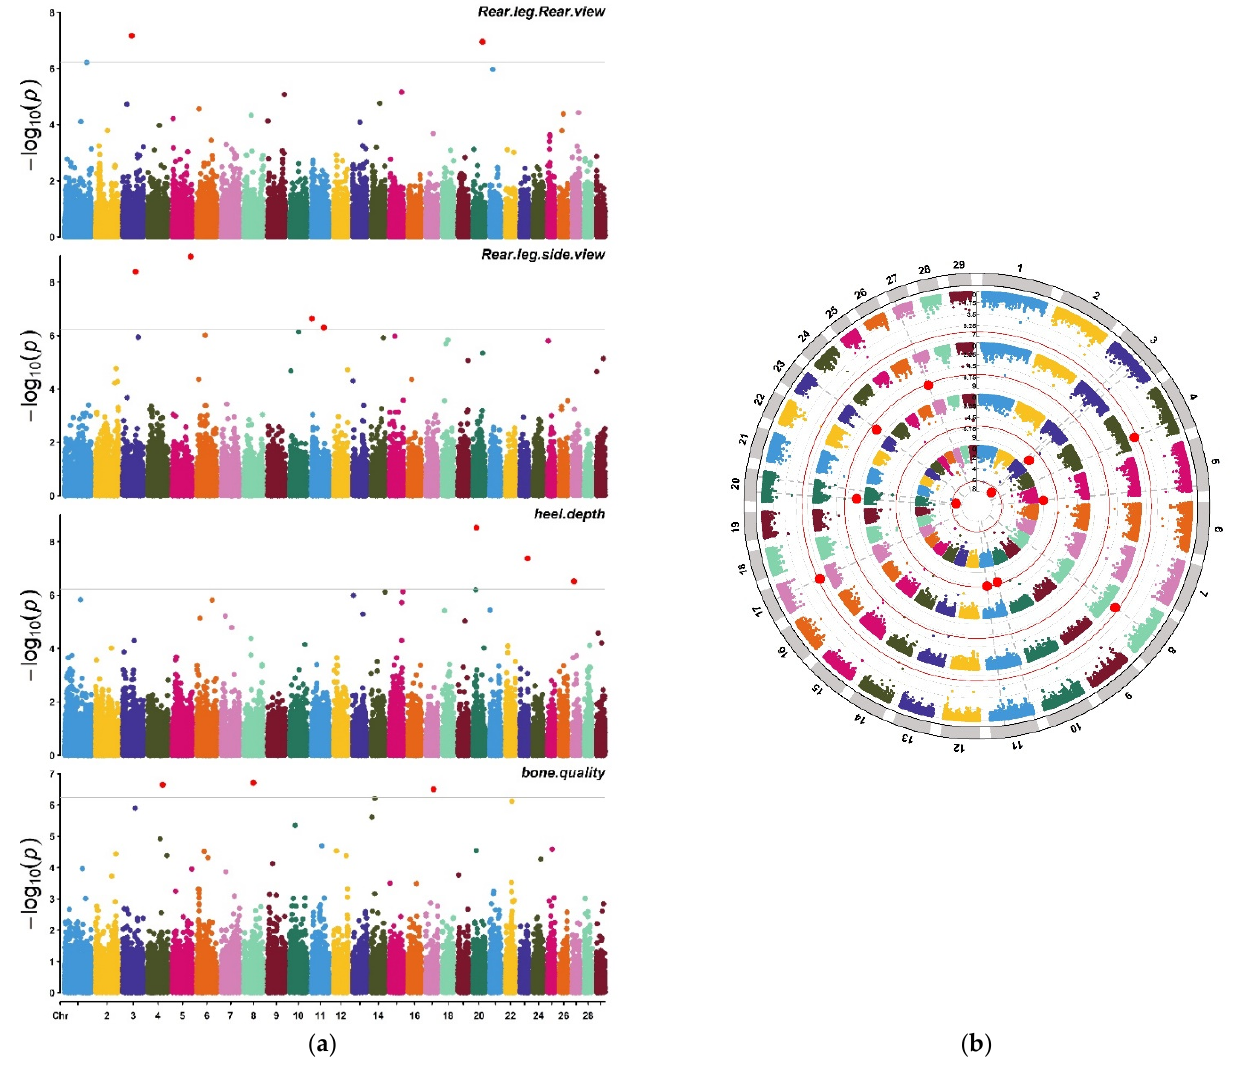
Figure 4. Manhattan from GWAS for feet and leg traits in Chinese Holstein cattle. Manhattan plot in which the genomic coordinates of SNPs are displayed along the horizontal axis, the negative logarithm of the association p value for each SNP is displayed on the vertical axis and the green line indicates the significance threshold level after Bonferroni correction ( a ). Circular Manhattan plot, the four feet and leg conformation traits are plotted from the outside to the inside, respectively ( b ).